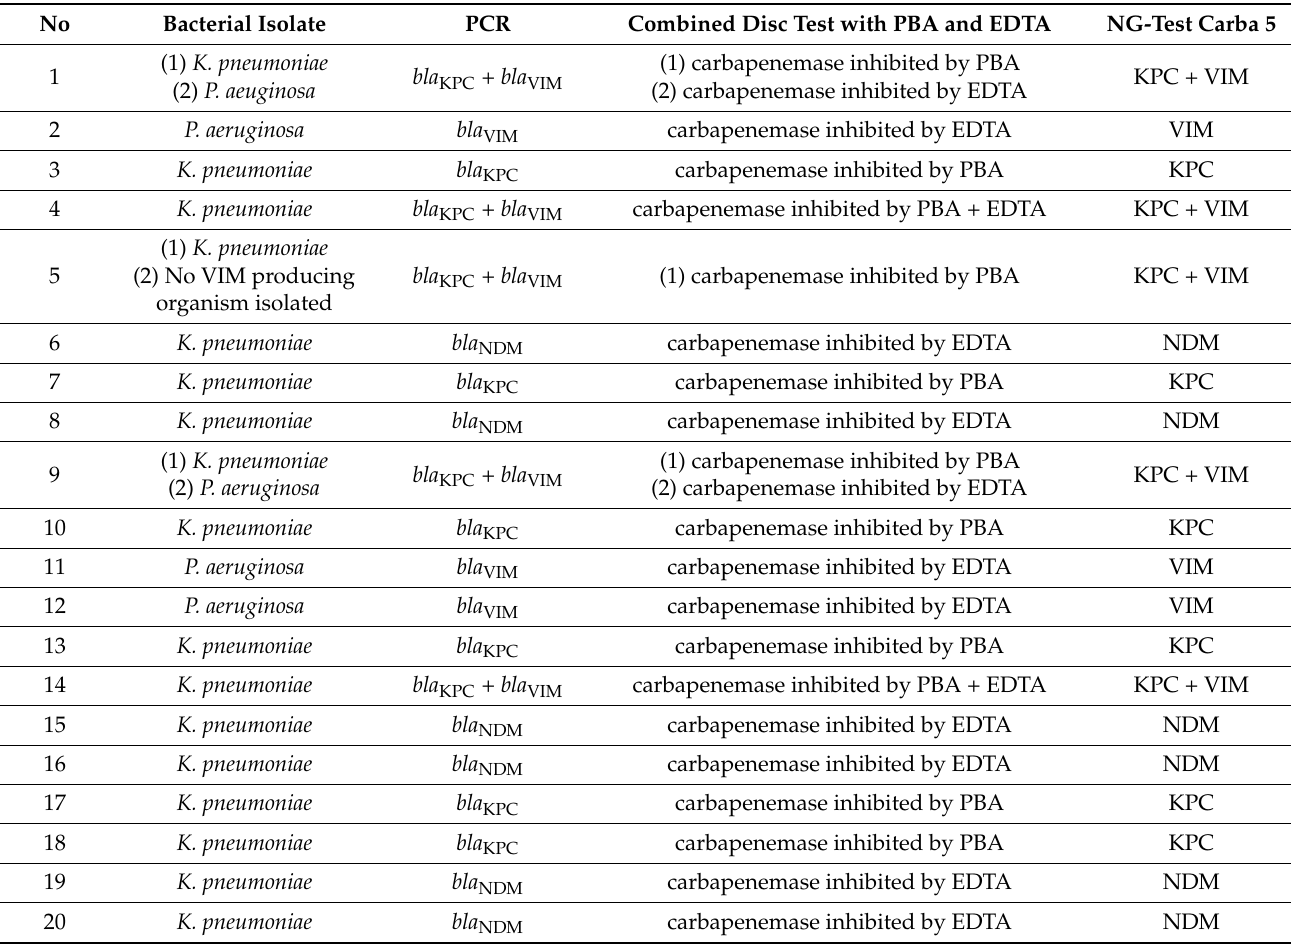
Table 1. Bacterial Culture, PCR, combined disc test with PBA and EDTA, and NG-Test CARBA 5 results for carbapenemase- positive rectal samples (Total N =